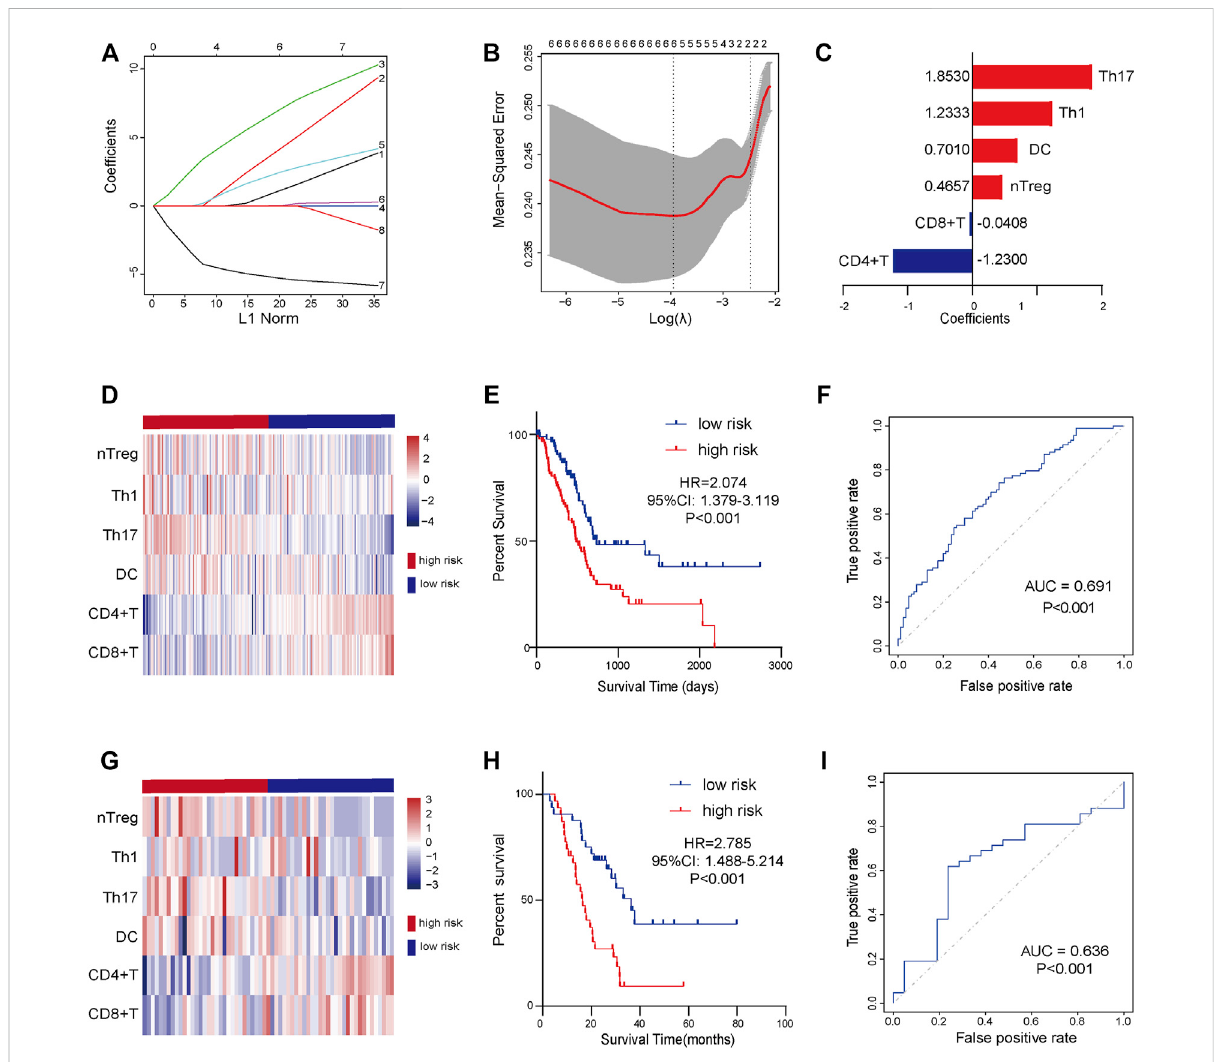
FIGURE 2 TheestablishmentandvalidationofTILs-relatedsignatureinPaCa. (A) LASSOcoef fi cientpro fi lesof8selectedTILs. (B) 10-foldcross-validations result which identi fi edoptimalvalues ofthepenaltyparameter λ . (C) ThedistributionofLASSOCoxcoef fi cients intheTILs-relatedsignature. (D) The heatmapofsixTILsin fi ltratinglevelsinthetrainingset. (E) Patientsinthehigh-riskgroupexhibitedworseOScomparedtothoseinthelow-riskgroup inthetrainingset. (F) ROCanalysisinthetrainingset. (G) TheheatmapofsixTILsin fi ltratinglevelsinthevalidatedset. (H) Patientsinthehigh-risk group exhibited worse OS compared to those in the low-risk group in the validated set. (I) ROC analysis in the validated